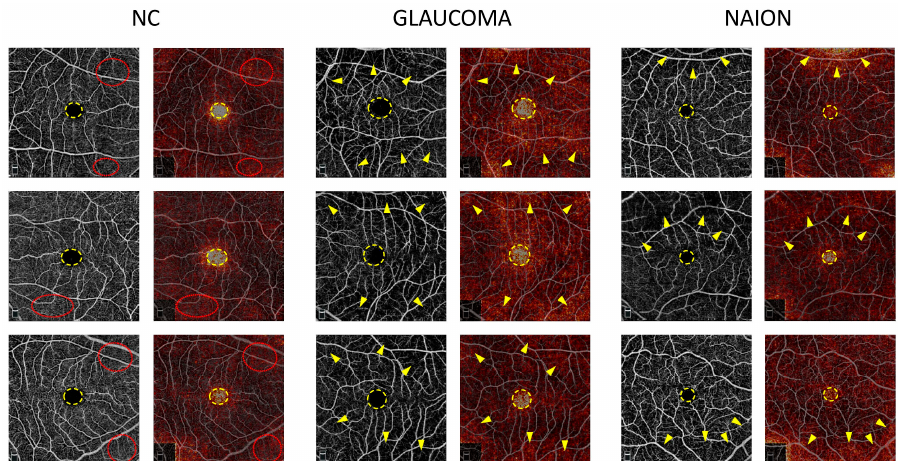
Figure 3. Examples of macular superficial capillary plexus (SCP) attribution maps. SCP optical coherence tomography angiography (OCTA) for glaucoma, non-arteritic anterior ischemic optic neuropathy (NAION) and normal control (NC) correct attributions ( left column ) are represented with the corresponding attribution maps ( right column ). In every case, the foveal avascular zone (FAZ) (dotted yellow circle) appears as a high spot. While the high vessel density areas (red dotted circles) are highlighted on the NC attribution maps, the low vessel density areas (yellow arrows) are emphasized on the glaucoma and NAION attribution maps.